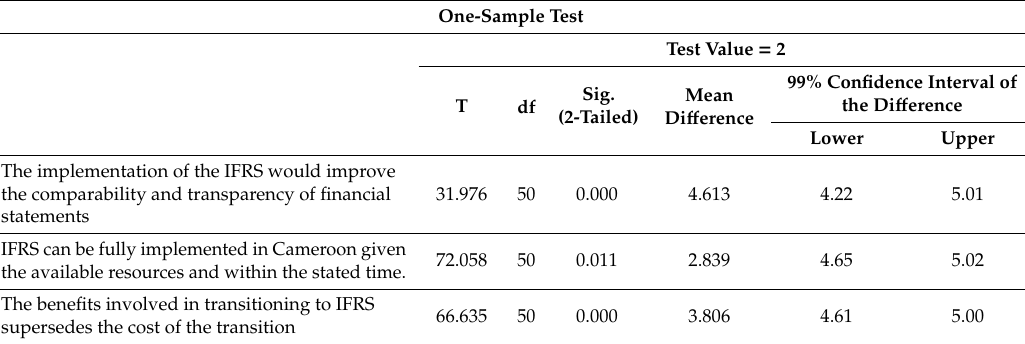
Table 8. Hypothesis testing